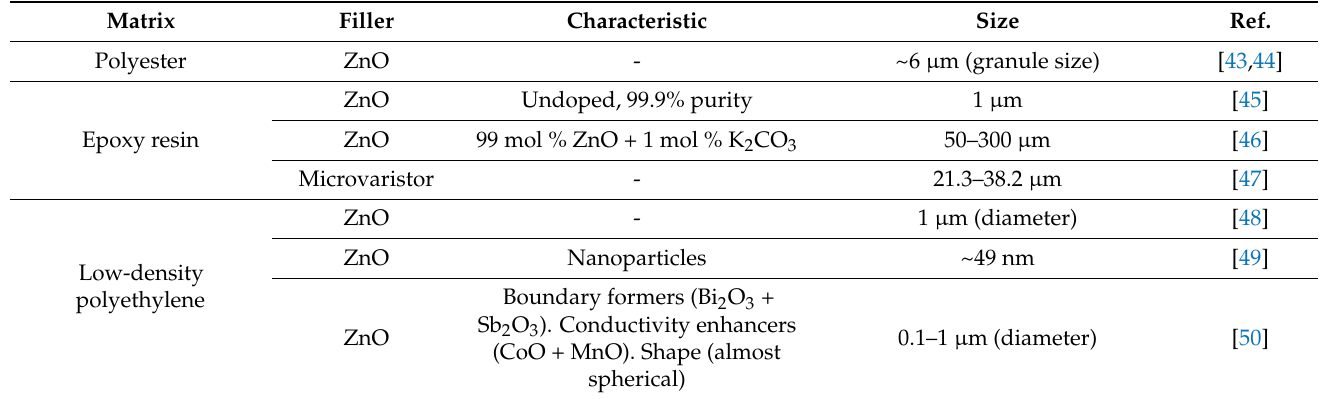
Table 1. Characteristics of ZnO fillers used in nonlinear composites.